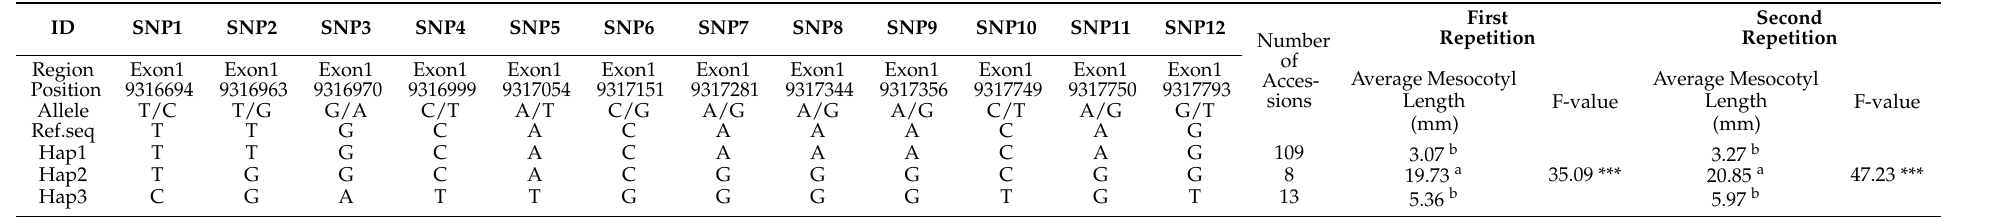
Table 2. Results of haplotype analysis of Os01g0269800